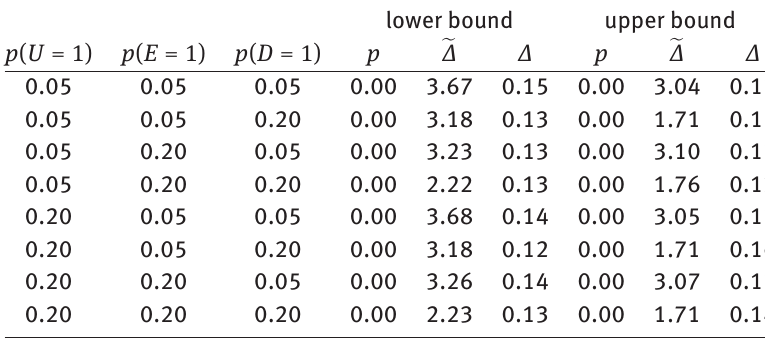
Table 1: Simulation results with σ = 1 . p is the proportion of times that the assumption-free bound was sharper than DV’s (cid:2) Δ are the mean absolute distance between the log of the bound and the log of the true causal risk ratio, for DV’s bound; Δ and bounds and the assumption-free bounds,